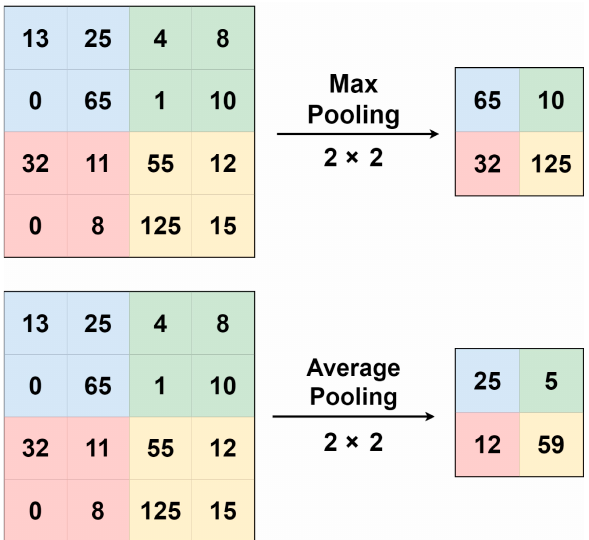
Figure 3. Example of a pooling layer showing both max pooling and average pooling. The flattened layer converts the multidimensional data to one dimension before forwarding them to a fully connected layer.